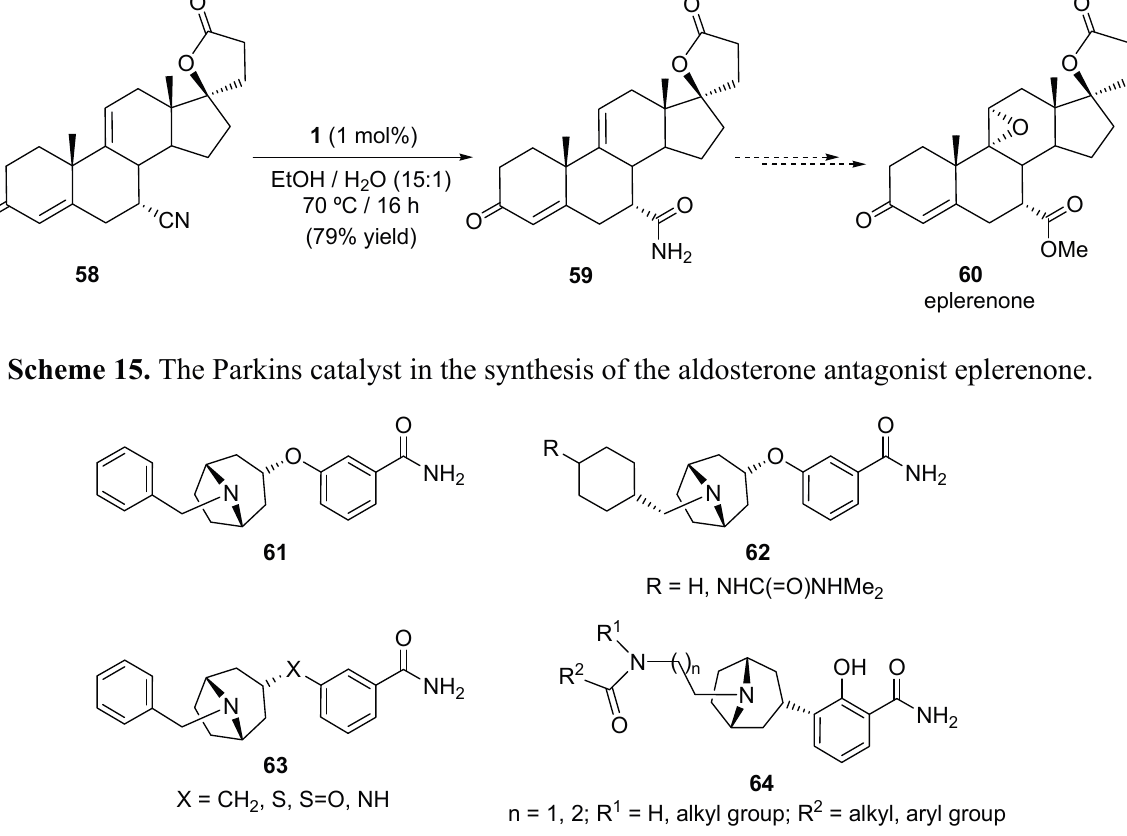
Figure 5. Structure of the opioid receptor antagonists 61-64